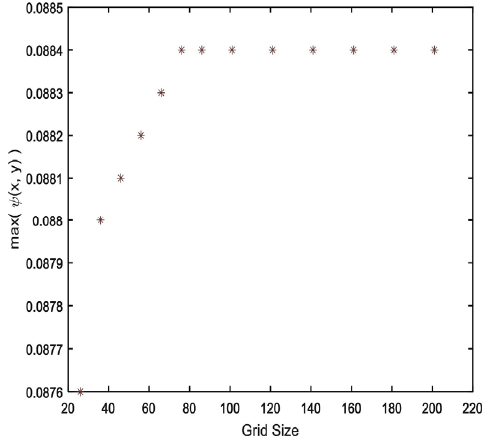
Figure 5. Grid Independence Study.